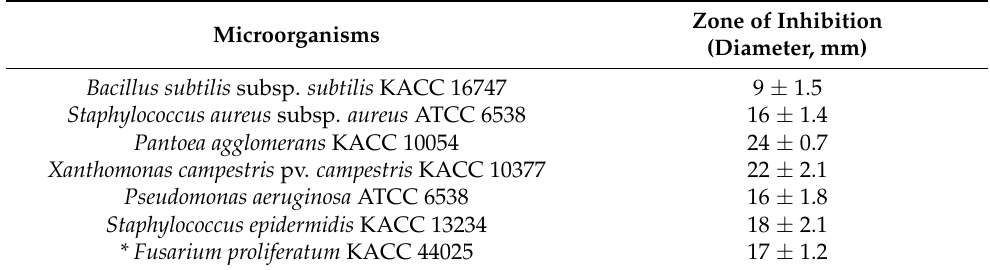
Table 2. Evaluation of antimicrobial activity against pathogenic microorganisms of Arthrobacter sp. GN70. All of the experiments were performed on R2A agar plates, except those indicated with a *, which were performed on PDA agar plates. The antimicrobial activity of the following strains was negative: A. niger KACC 42850; B. cinerea KACC 40573; C. gloesporioides KACC 40003; P.